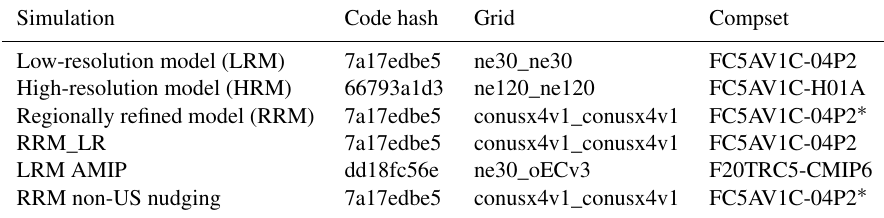
Table A1. EAMv1 simulation setup details.